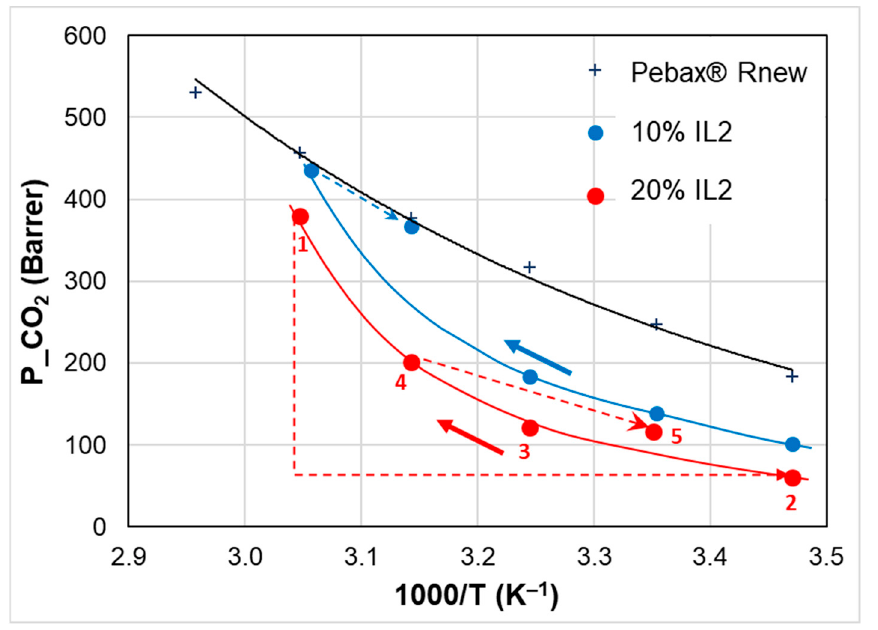
Figure 13. Temperature effect on CO 2 permeability for Rnew (plus sign, +) and Rnew–IL2 (OOMmimPF 6 ) composite membranes at 20% (red circles) and 10% IL (blue circles).